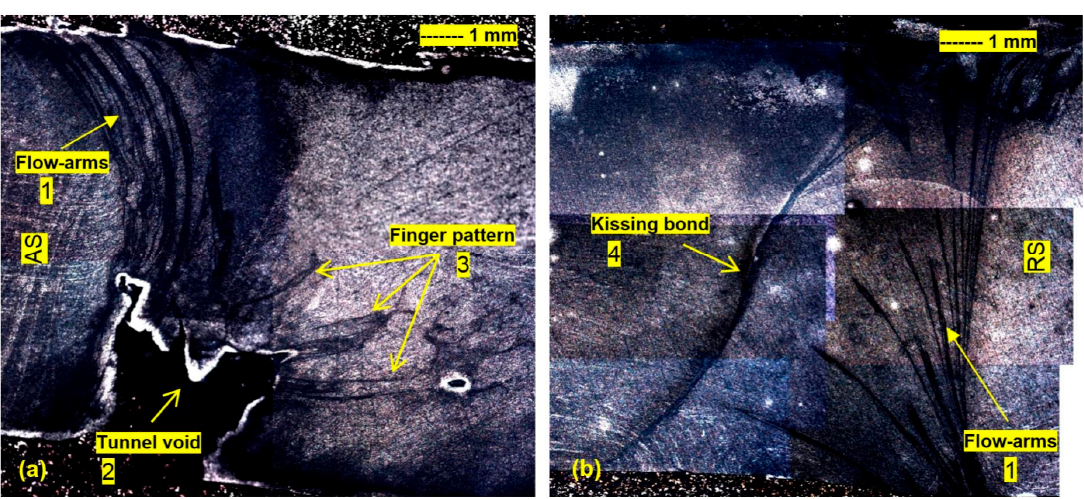
Figure 4. Photomontage microfeatures of the BFSW weld at the transverse cross-section (revealed by Reagent C). ( a ) AS border, ( b ) RS border. (1) flow-arms, (2) tunnel void, (3) finger patterns, and (4) kissing bond.